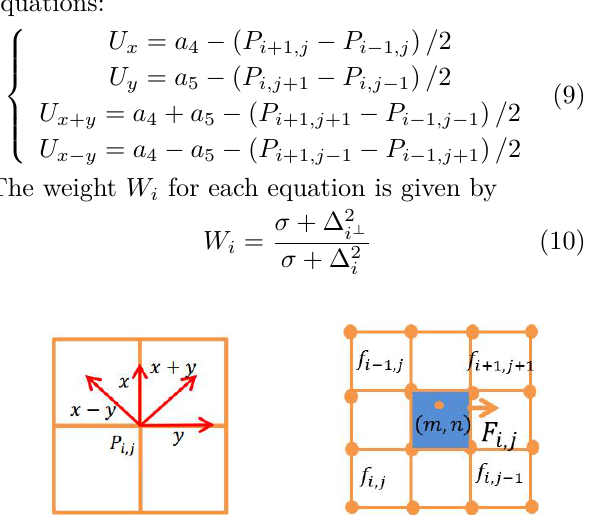
Fig. 4 Four directions. Fig. 5 Overlap region for four neighboring